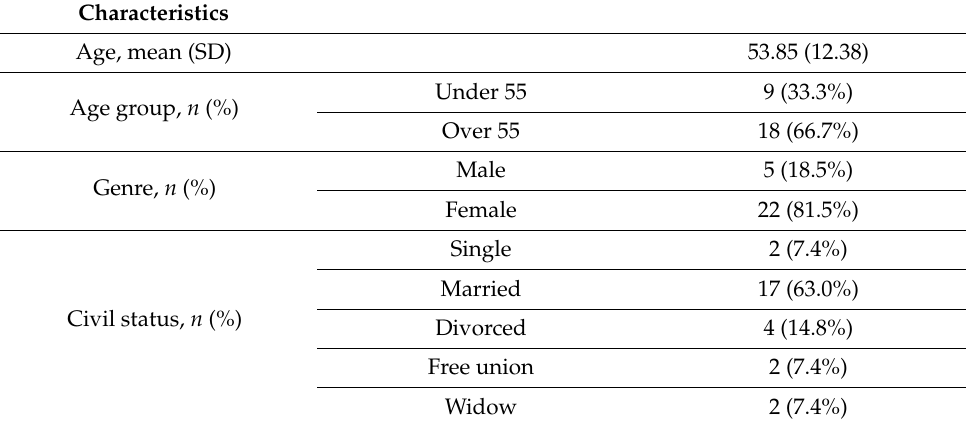
Table 1. Sociodemographic characteristics.